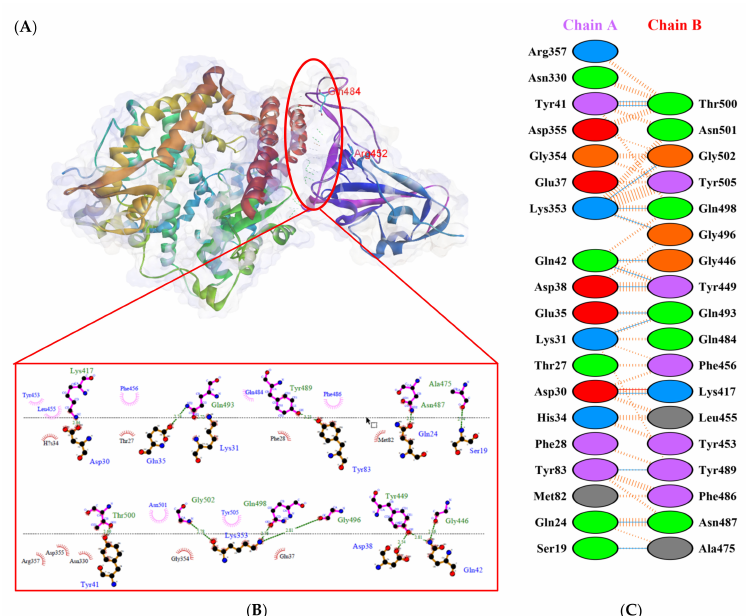
Figure 5. Protein–protein docking representation of hACE2 and RBD Delta complexes. ( A ) The complex’s binding interface; ( B ) The amino acid’s binding interaction; and ( C ) The interaction representation, which includes hydrogen ( ), salt bridges ( ), and non-bonded ( ) interactions. Chain A represents hACE2 and chain B represents RBD Delta. Residue colors: positive (blue): H,K,R; negative (red): D,E; neutral (green): S,T,N,Q; aliphatic (grey): A,V,L,I,M; aromatic (purple): F,Y,W; Pro & Gly (orange): P,G.